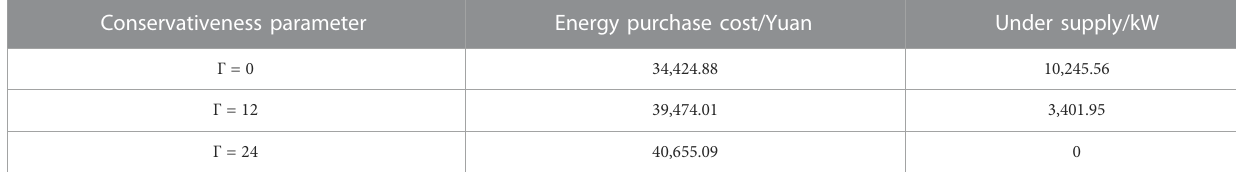
TABLE 1 Simulation results of scenario 1.